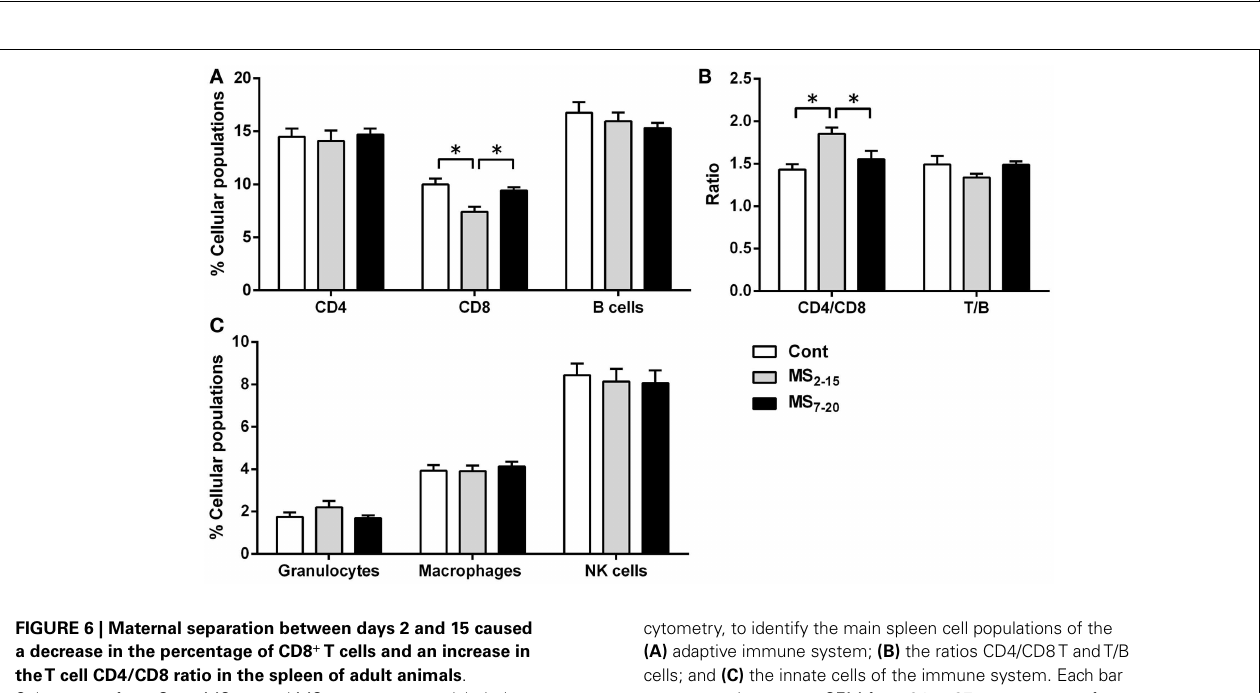
FIGURE 5 | Maternal separation did not alter the proportion of the main thymic populations but thymocytes from MS 2–15 animals presented increased resistance to dexamethasone treatment . (A) Thymocytes from Cont, MS 2–15 , and MS 7–20 groups were stained with antibodies specific for D4 and CD8 and analyzed by flow cytometry. Each bar represents the mean + SEM from 19 to 26 rats per group from two independent